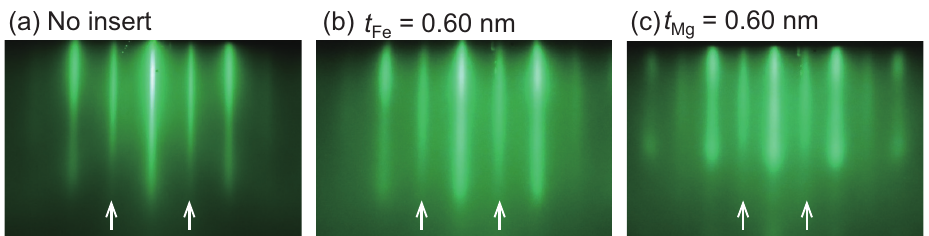
Figure 2. Reflection high-energy electron diffraction (RHEED) images for the surface of the upper CFMS layer for azimuth of CFMS <110>. Layered films with ( a ) no insert; ( b ) Fe inserts of 0.60 nm, and ( c ) Mg inserts of 0.60 nm. The arrows indicate the superlattice streaks from the L 2 1 phase of CFMS.